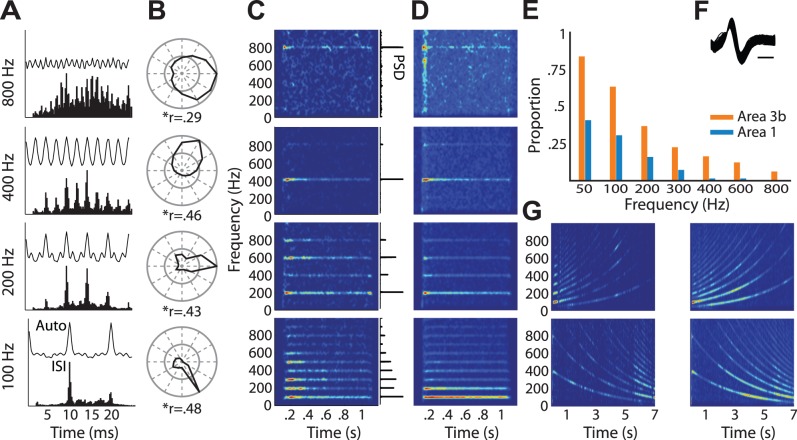
Temporal patterning in cortical responses to sinusoidal stimulation.(A) Autocorrelations (top) and interspike interval histograms (bottom) for one neuron in area 3b, whose responses are entrained with the stimulus up to 800 Hz. (B) Phase histograms along with vector strength (r) for the same neuron as in (A) showing action potentials tended to occur during a restricted phase of each stimulus cycle. (C) Spectrograms for the same neuron as in (A), with corresponding power spectral densities (PSD) in the insets to the right. Note that the temporal patterning begins almost immediately and lasts for the duration of the stimulus, and that the fundamental frequency in the neural response reflects the frequency of the sinusoid. (D) Average spectrograms computed from the population of neurons that exhibited significantly phase-locked responses above 200 Hz (11 neurons in area 3b, five neurons in area 1). (E) Proportion of neurons in areas 3b and 1 that produced phase-locked responses at each frequency tested. (F) Traces of 1,000 action potential waveforms for the neuron whose responses are shown in (A–C); scale bar = 250 µs. (G) Spectrograms of neural responses to sine-sweep stimuli with either upward or downward sweeps between 50 and 400 Hz (left, same neuron as in (A); right, average over phase-locked population).